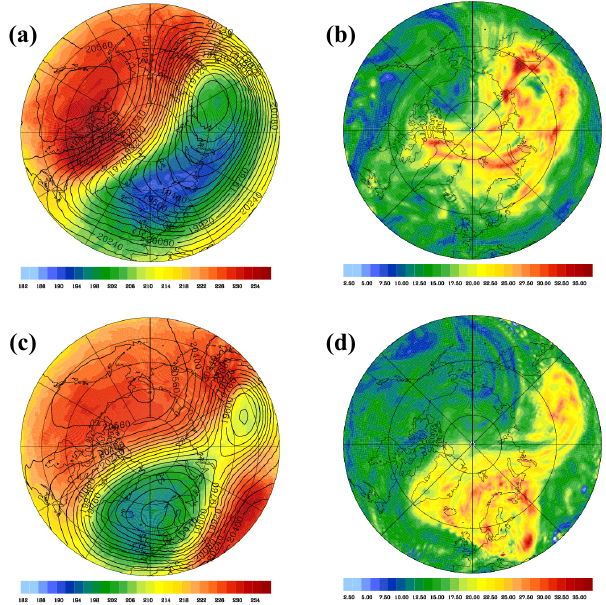
Fig. 3. Panels (a) and (c) : absolute Temperature (K, colour shaded) and geopotential height (m; black contour lines) at the 50hPa pres- Figure 3: Panels (a) and (c): Absolute Temperature (K, colour shaded) and geopotential 4 sure surface. Panels (b) and (d) : scaled or modified potential vor- height (m; black contour lines) at the 50 hPa pressure surface. Panels (b) and (d): Scaled or 5 ticity PV · (2 /420K) − 9 / 2 (PVU; colour shaded) at 2 = 425K (see modified potential vorticity PV·( Θ /420 K) -9/2 (PVU; colour shaded) at Θ = 425 K (see Lait, 6 Lait, 1994). Operational ECMWF analyses interpolated at a regu- 1994). Operational ECMWF analyses interpolated at a regular 0.5 ° x 0.5 ° latitude/longitude 7 lar 0.5 × 0.5 ◦ latitude/longitude grid for 24 January 2010 (a, b) and 5 February 2010 (c, d) . grid for 24 January 2010 (a, b) and 5 February 2010 (c, d). 8